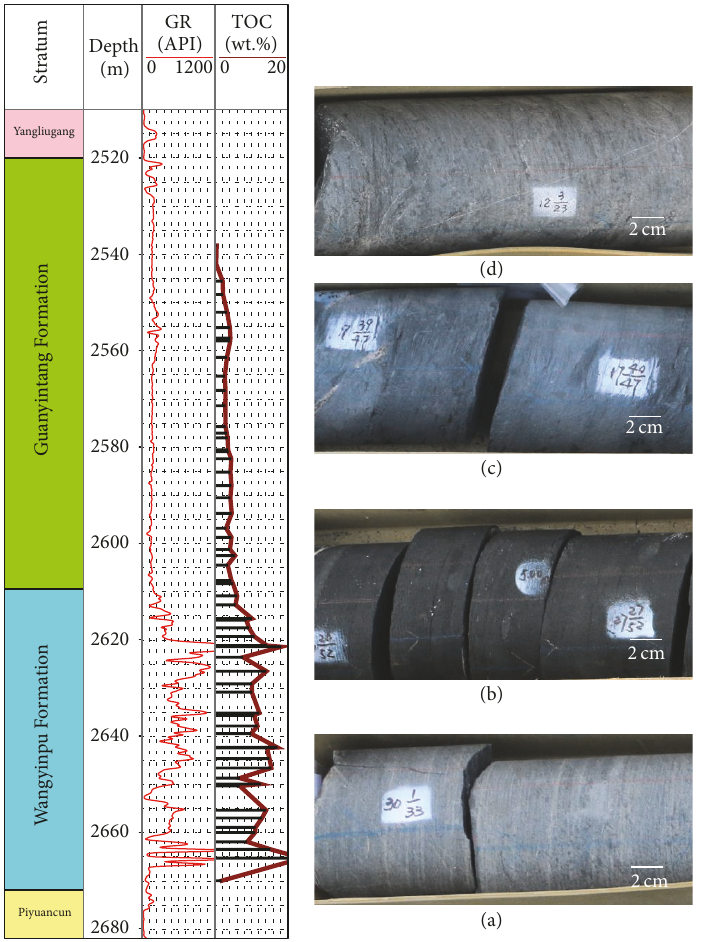
Figure 2: A stratigraphic column and core photos of Upper Ediacaran, Lower and Middle Cambrian of Jiangye-1 well. (a) Ediacaran Piyuancun Formation 2675 m, grey siliceous dolomite. (b) Lower Cambrian Wangyinpu Formation 2638 m, dark siliceous shale. (c) Lower Cambrian Guanyintang Formation 2546 m, dark grey siliceous shale. (d) Middle Cambrian Yangliugang Formation 2511m, grey micrite. See Figure 1 for the location of the well site.